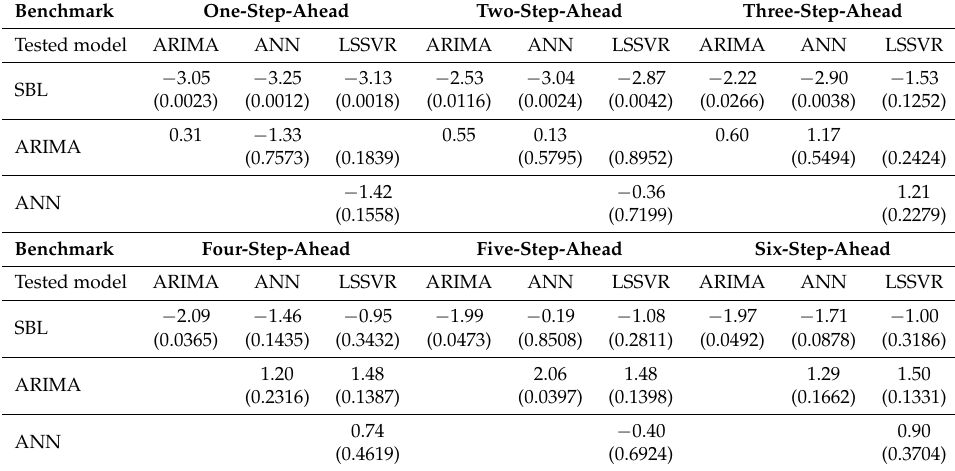
Table 4. The Diebold–Mariano (DM) test results for single models on WTI crude oil prices.